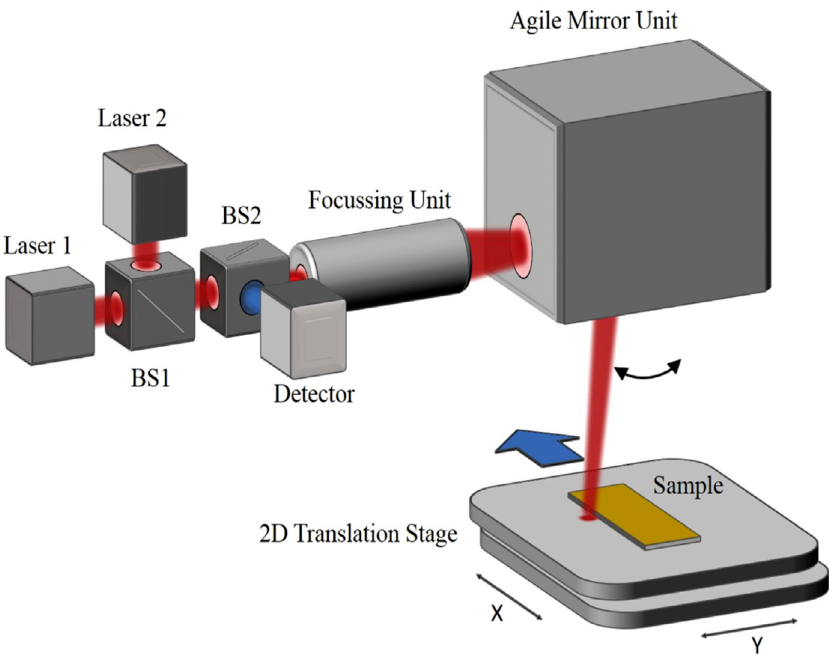
Figure 8. Schematic view of the mid-infrared (MIR) scanner setup with confocal mounted detector [23].